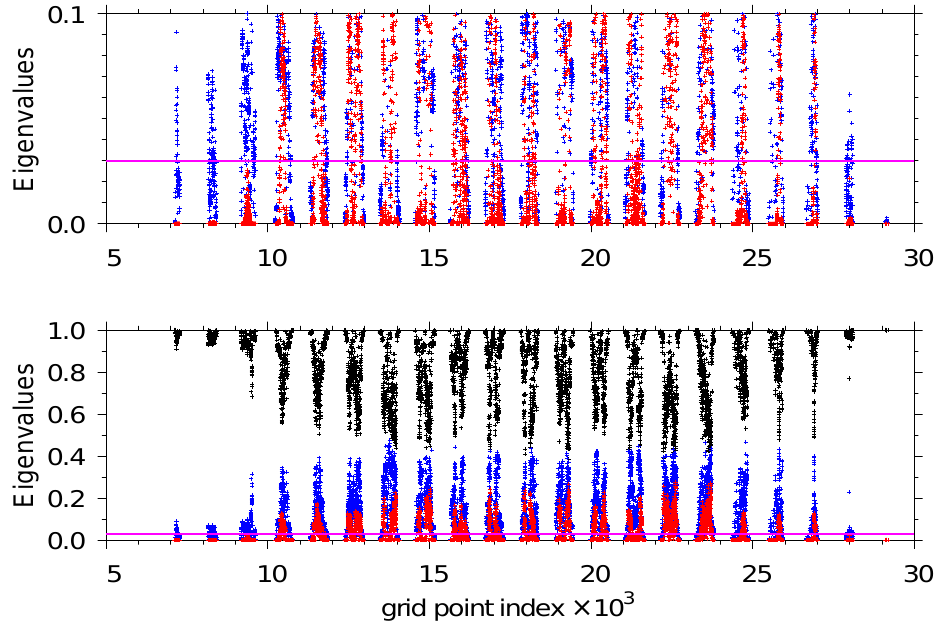
Fig. 2. The lower panel shows the eigenvalues for each grid point that has at least 50 radar observations associated with it. For each point, the largest eigenvalue is shown in black, the second largest in blue, and the smallest in red. The horizontal axis is just the grid point index obtained by traversing the grid in C-style order(the last index varying the fastest). The horizontal line in magenta indicates the threshold value used to accept the associated velocity. The upper panel is a zoom-in of the lower panel.